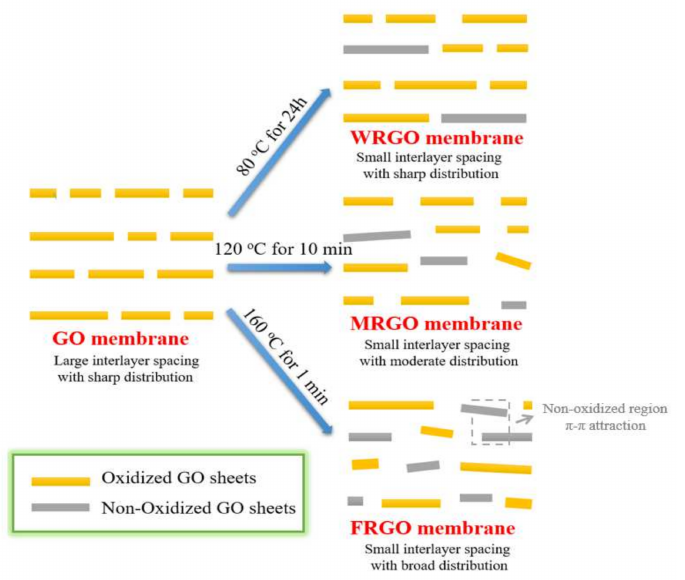
Figure 4. The schematic illustration of the nano-structures of the GO membrane, WRGO membrane, MRGO membrane, and FRGO membranes under the different thermal reduced treatment